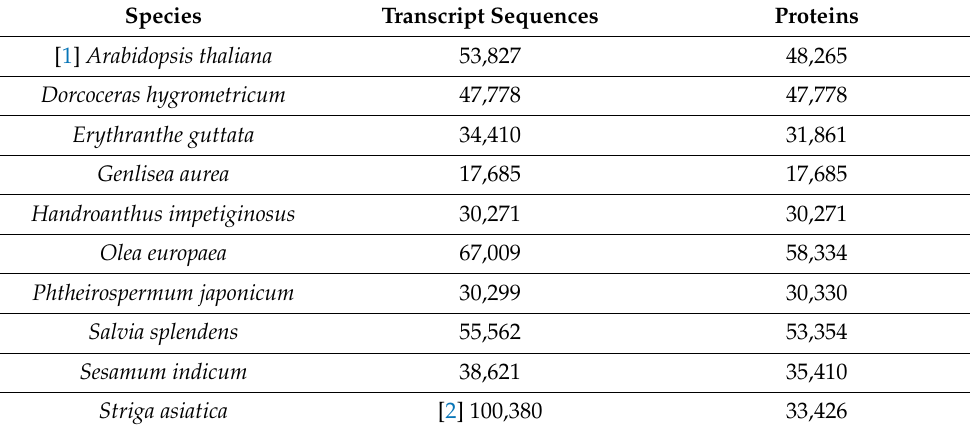
Table 3. The completed genome sequences within the order Lamiales range widely in transcript sequence set size, from 17,685 transcript sequences for the carnivorous G. aurea to 67,009 transcript sequences for the European olive. [1] A. thaliana falls within the order Brassicales rather than the order Lamiales . [2] The transcript sequence set for S. asiatica contains redundant accessions that greatly outnumber the proteins listed for this